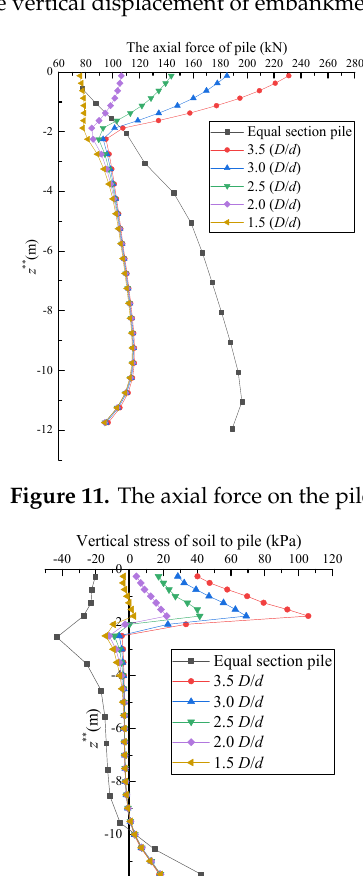
Figure 12. The vertical stress curve of the soil to pile.